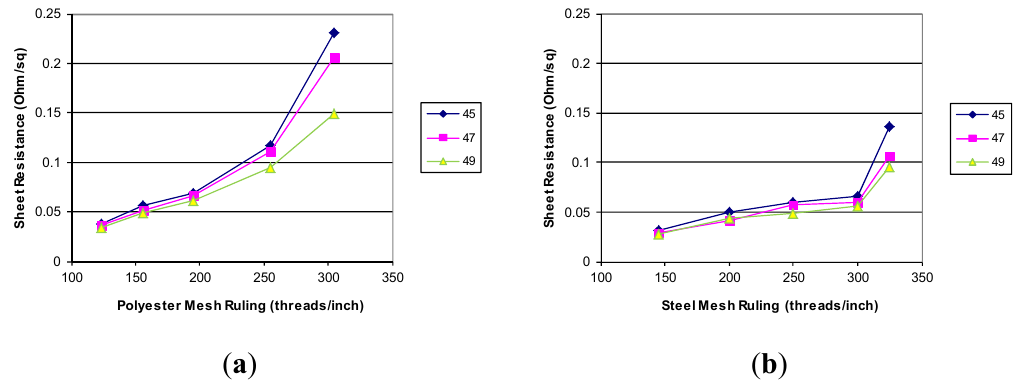
Figure 2 . The effect of mesh ruling on the polymer sheet resistance printed through the ( a ) polyester and ( b ) stainless steel meshes for each silver proportion.